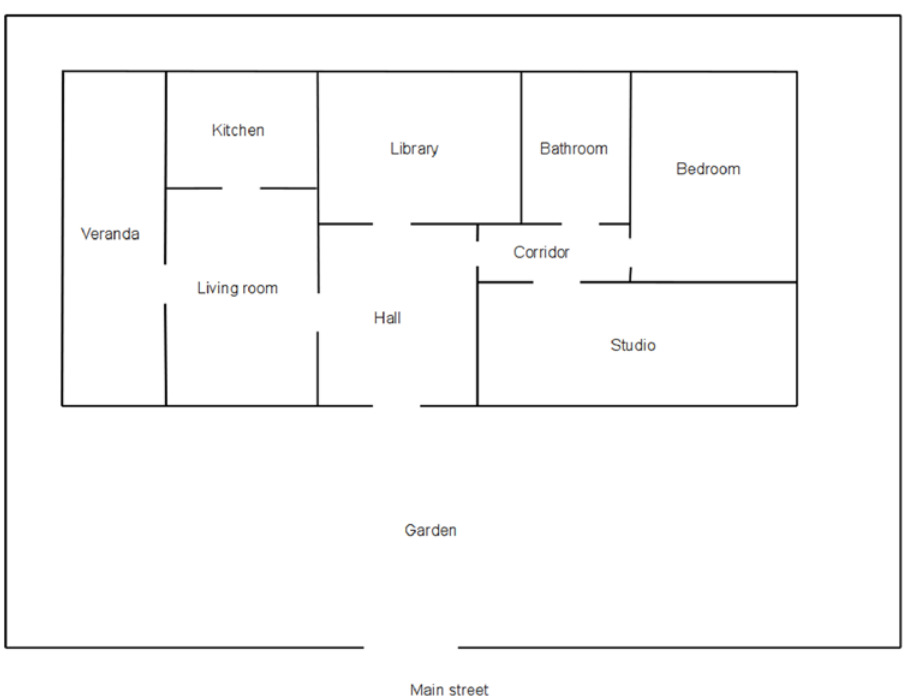
Fig 6. Map of the virtual house used to build the sentences for the test set of the virtual-environment dataset.